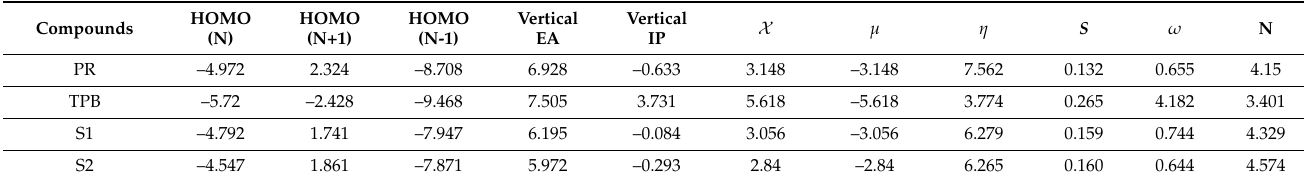
Table 7. Shows the calculated HOMO(N), HOMO (N + 1), HOMO (N-1) energy bands, chemical potential ( µ ), electronegativity ( X ), global hardness ( η ), global softness ( S ), and global electrophilicity index ( ω ) for tetraphenylborate, procainamide (IE, in eV) and its